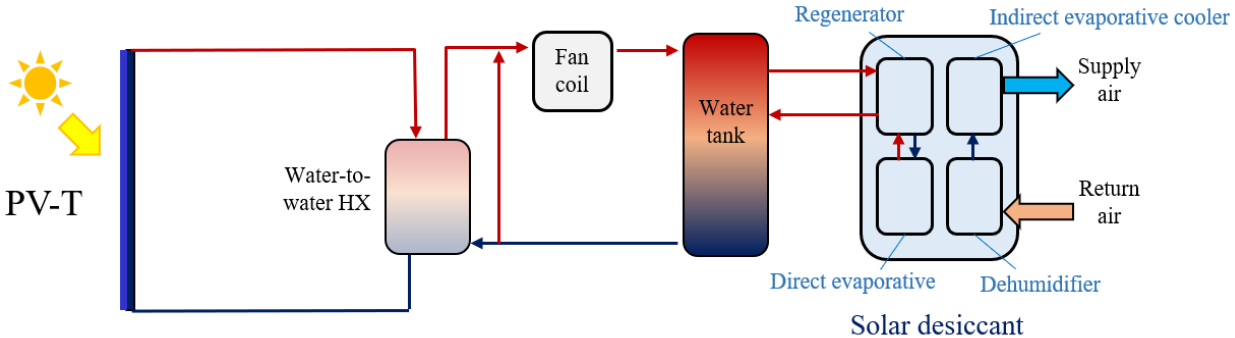
Figure 9. Schematic diagram of the BIPV-T-driven liquid desiccant cooling system presented in